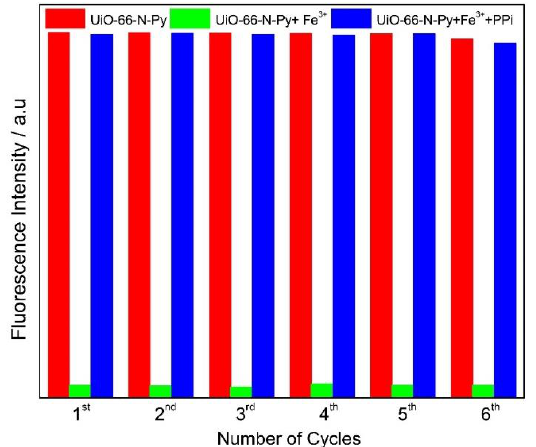
Figure 10. Bar diagram depicting the recyclability of UiO-66-N-Py, fluorescence quenching with UiO- 66-N-Py + Fe 3+ , regeneration of fluorescence with UiO-66-N-Py + Fe 3+ + PPi up to 6 cycles.